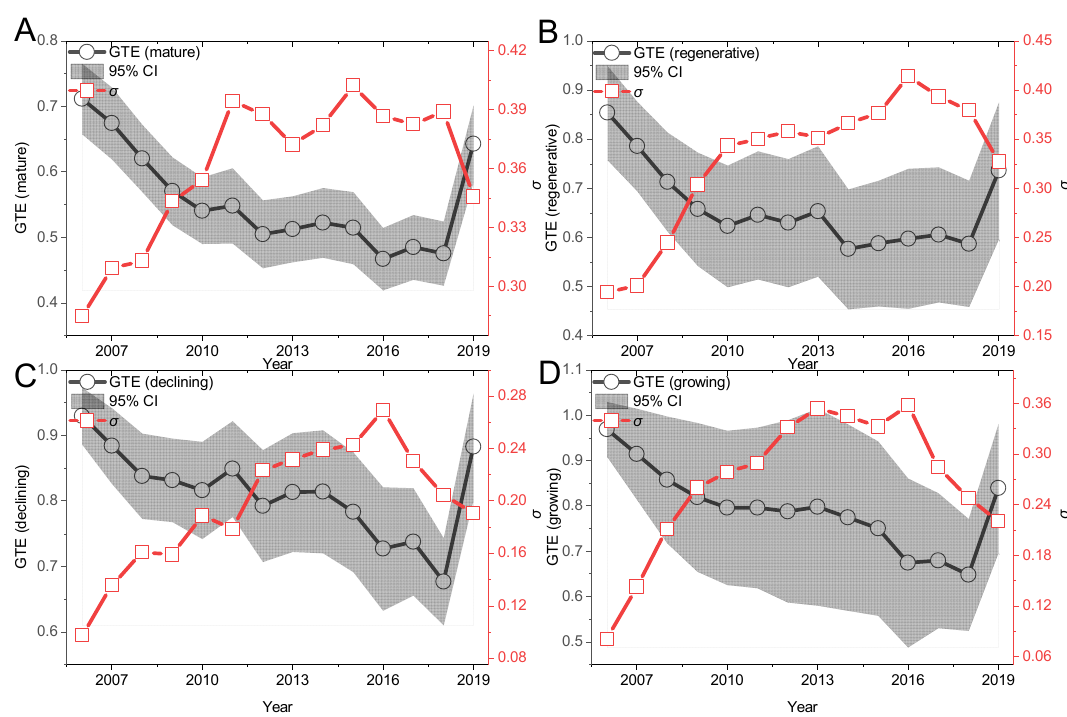
Figure 3. The Trend of GTE in Four Types of Mining Cities from 2006 to 2019. Note: ( A – D ) represent mature, renewable, declining and growing mining cities respectively. The shaded area represents the 95% confidence interval (CI). 𝜎 Represents the convergence trend of MTE annual mean [22].